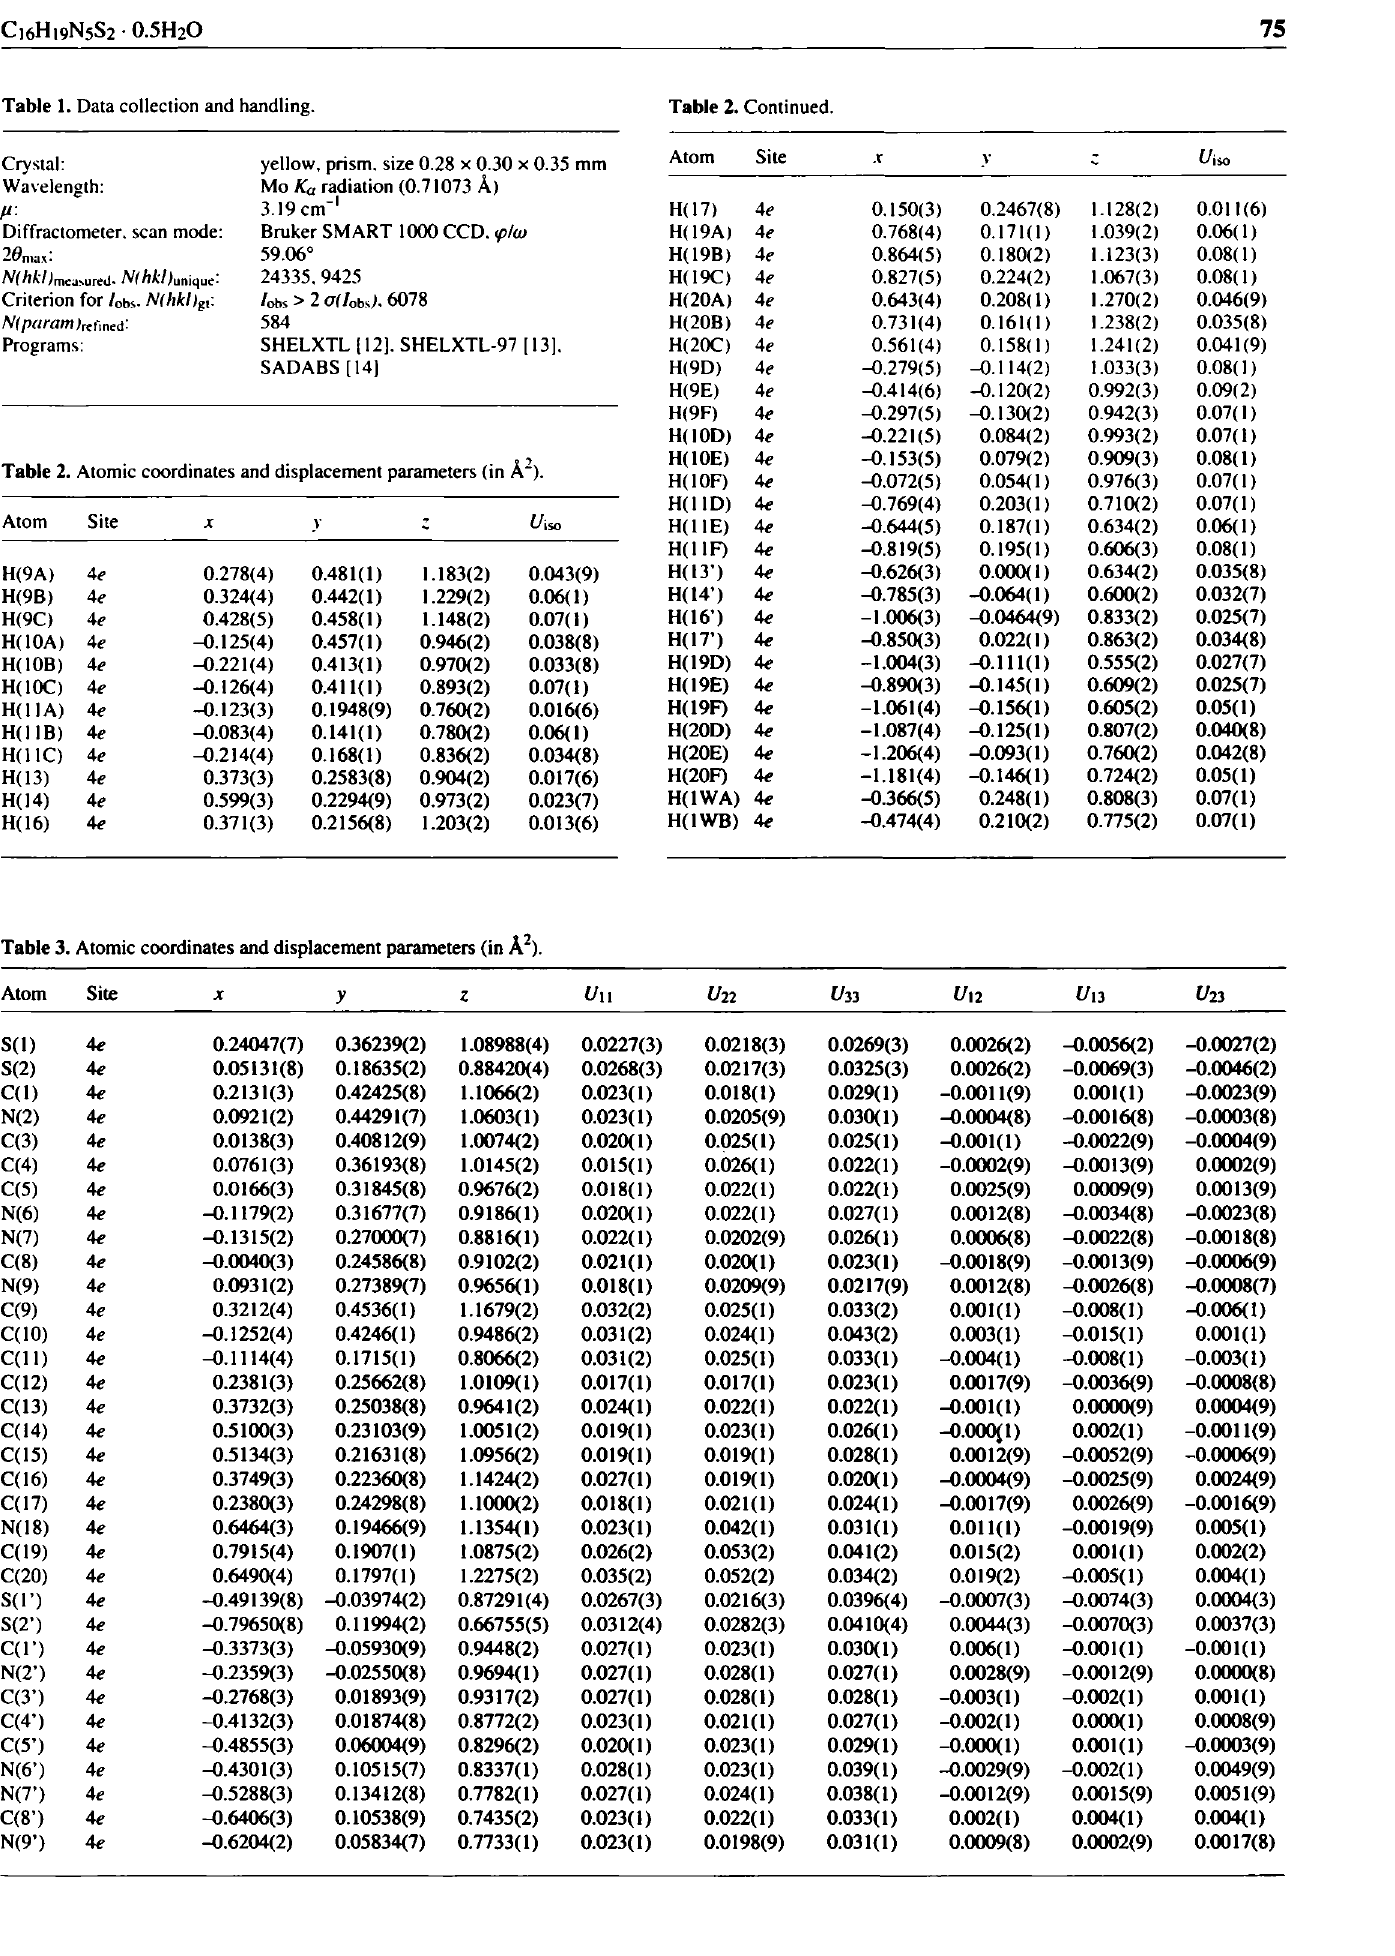
Table 3. Atomic coordinates and displacement parameters (in k 2